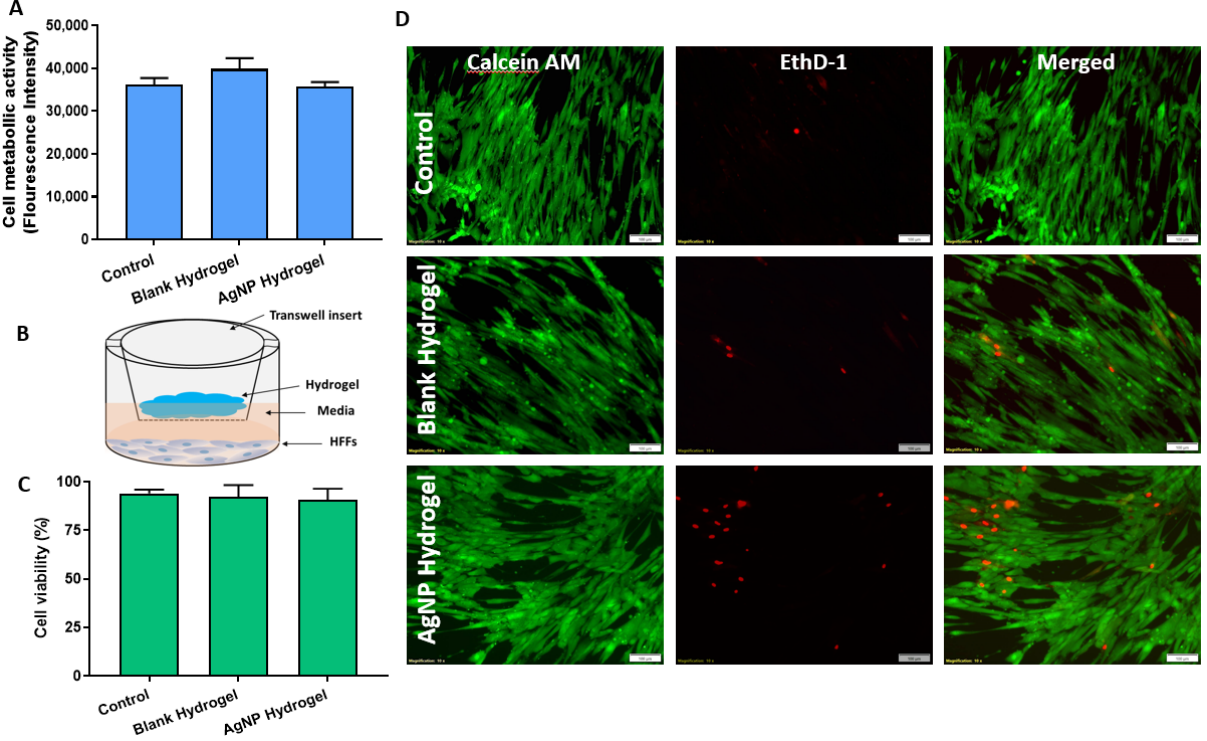
Figure 7. ( A ) Metabolic activity of human fibroblasts in the presence of blank and AgNP-loaded hydrogels as measured by the resazurin assay. ( B ) Schematic illustration of the indirect test of cell viability by transwell assay. ( C ) Corresponding statistical analysis of cell viability based on fluorescence microscopy images. ( D ) Representative fluorescence microscopy images of HFFs stained with calcein AM (green) and EthD-1 (red) to determine the ratio of Live/Dead cell. Data are shown as mean ±SD, scale bar 100 µm.